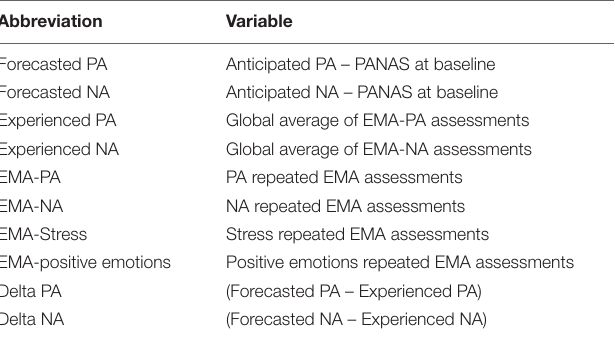
TABLE 1 | Summary of all the variables included in the analysis and their